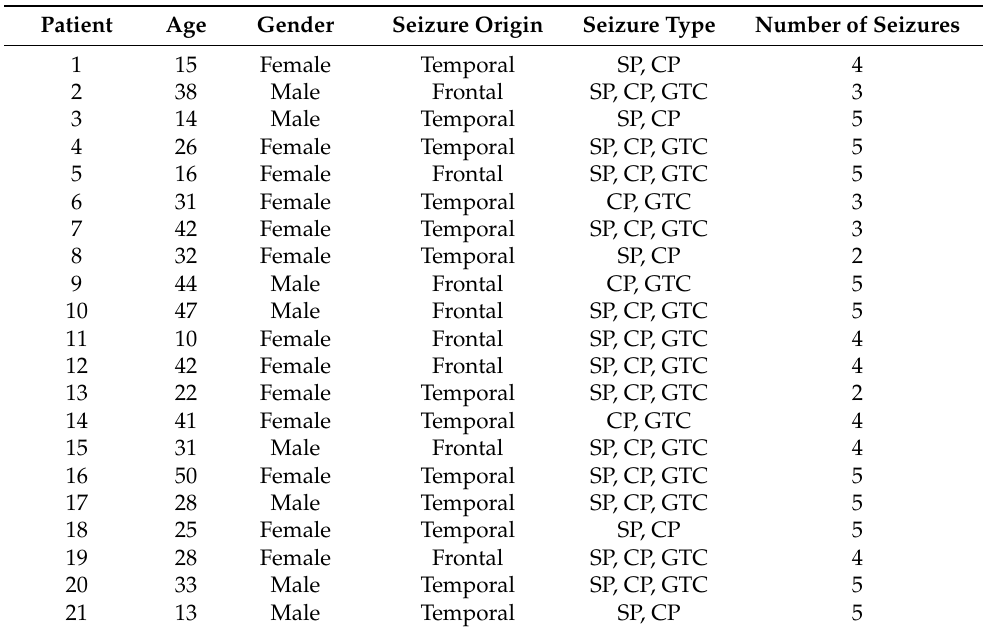
Figure 3. Exemplary EEGs from five samples of the Freiburg dataset.